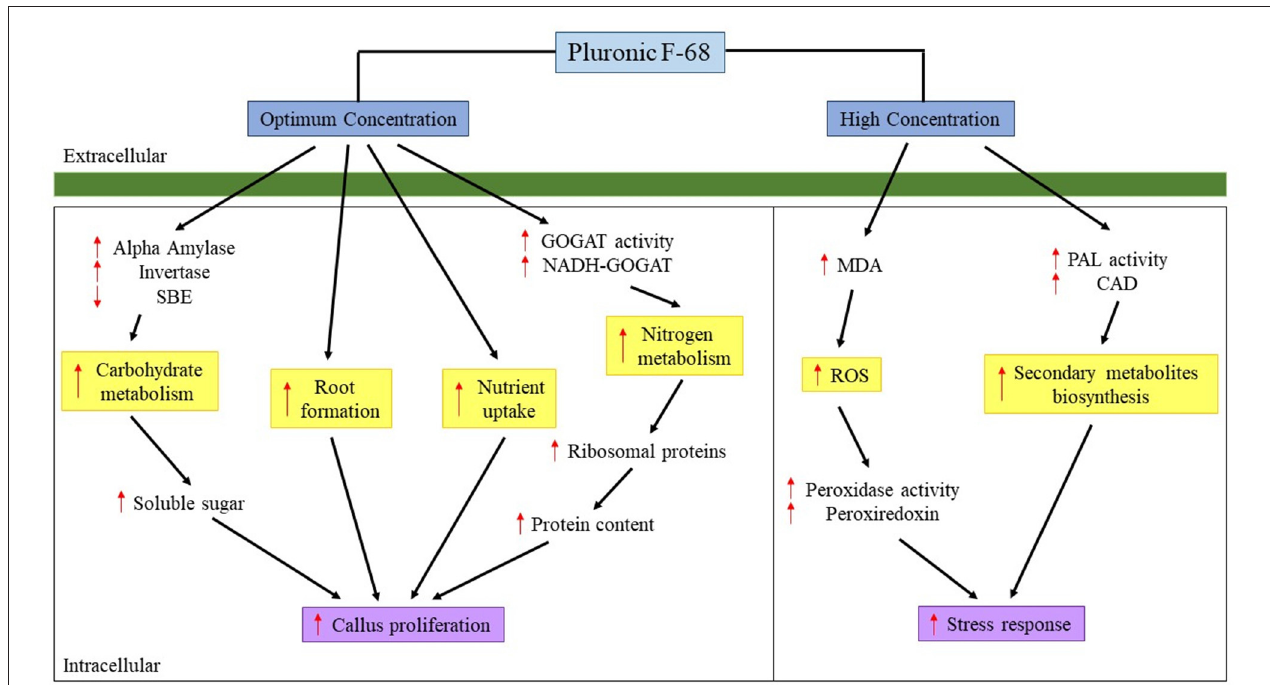
FIGURE 5 | Mechanism proposed on the roles of PF-68 in callus proliferation. CAD, cinnamyl alcohol dehydrogenase; GOGAT, glutamate synthase; MDA, malondialdehyde; NADH-GOGAT, NADH-dependent glutamate synthase; PAL, phenylalanine ammonia lyase; ROS, reactive oxygen species; SBE, starch branching enzyme; ↑ , increased; ↓ ,